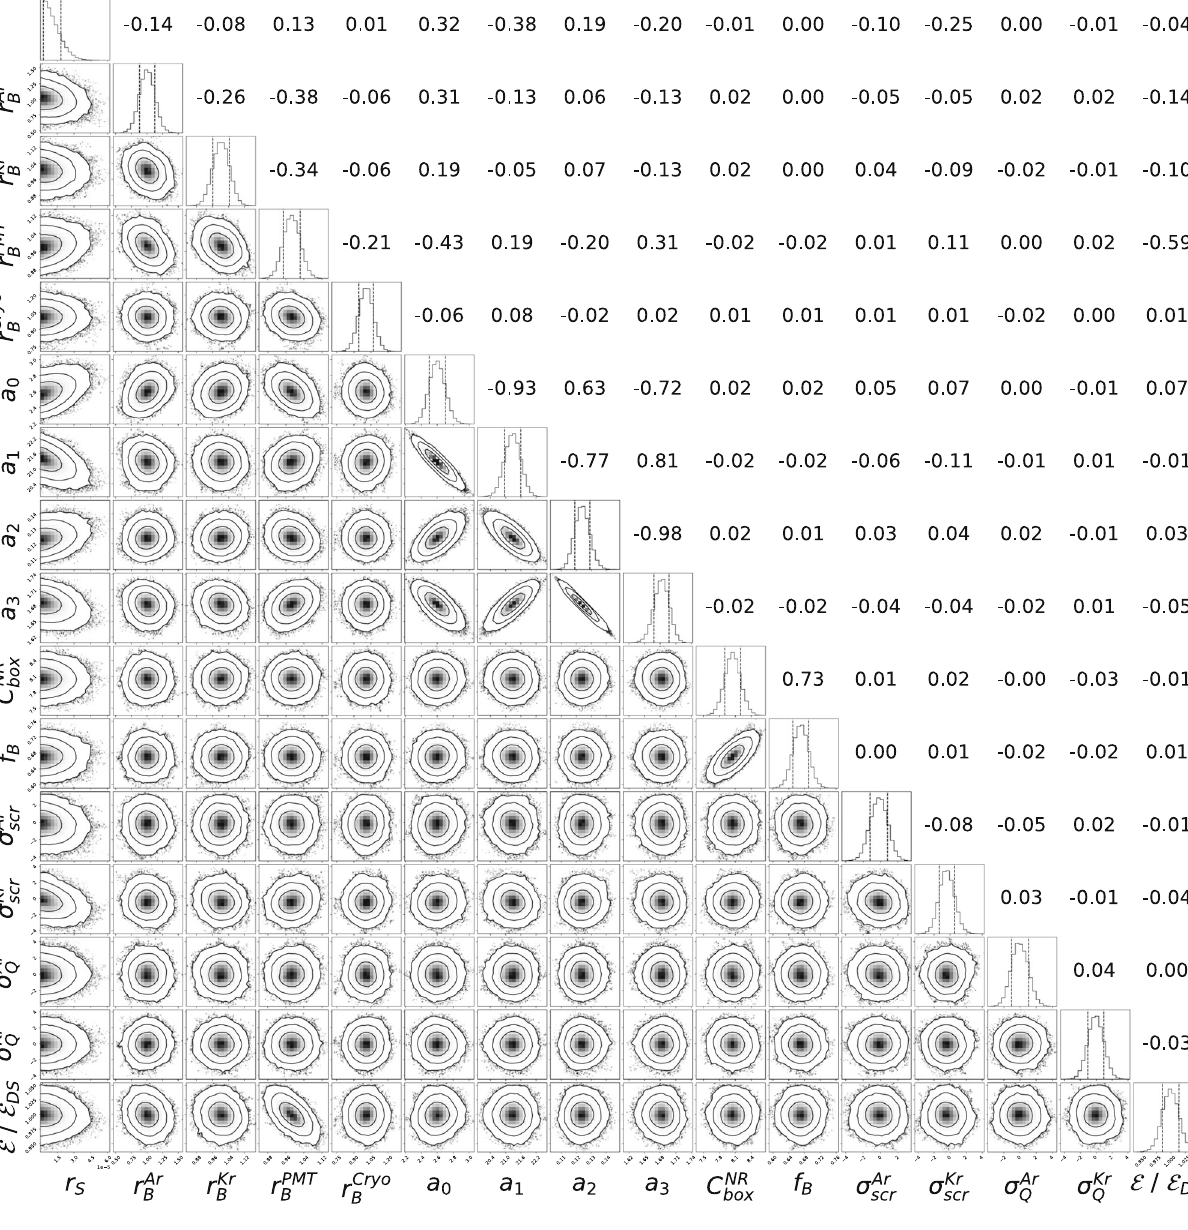
Fig. 10 Graphical representation of the joint posterior pdf of the fit on the expected pseudo-dataset assuming a DM mass m χ = 4 . 5 GeV / c 2 . The plots on the diagonal of the figure are the uni-dimensional pdf of each single parameter obtained by marginalizing on all the others. The bi-dimensional pdf s in the bottom-left corner of the figure give the joint